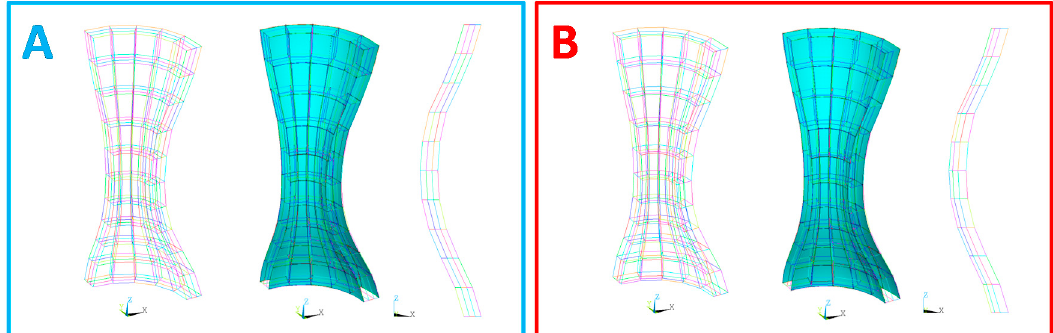
Figure 4. Adaptive cylindrical cell. ( A ) without radial bias; ( B ) with radial bias.